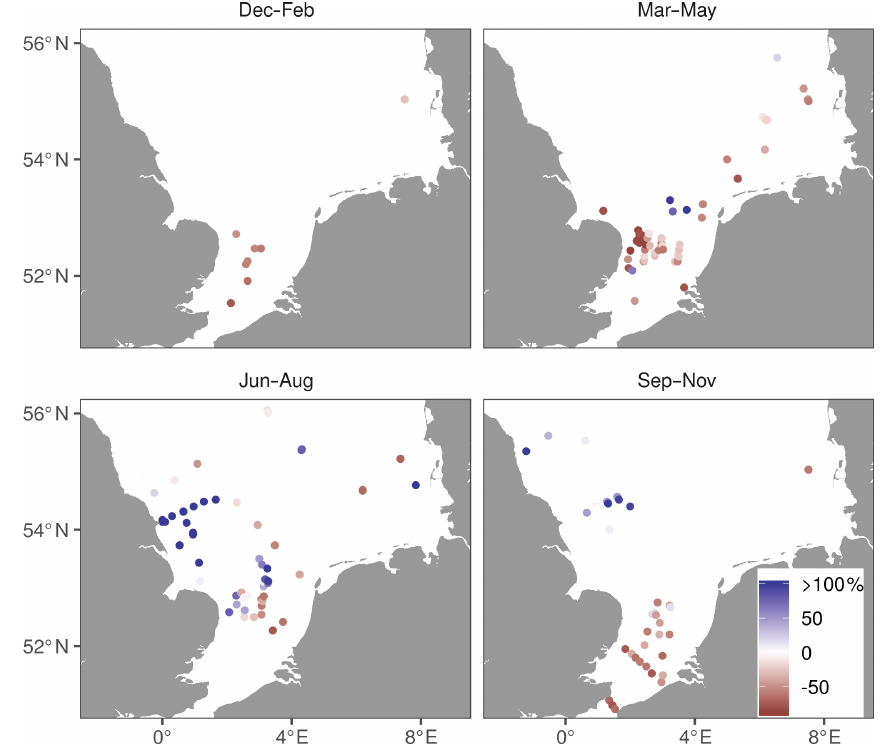
Figure 2. Seasonal changes in Secchi disc depth in the 20th century. Changes were estimated by detecting observations pre- and post-1950 that were in the same season and within 50km of each